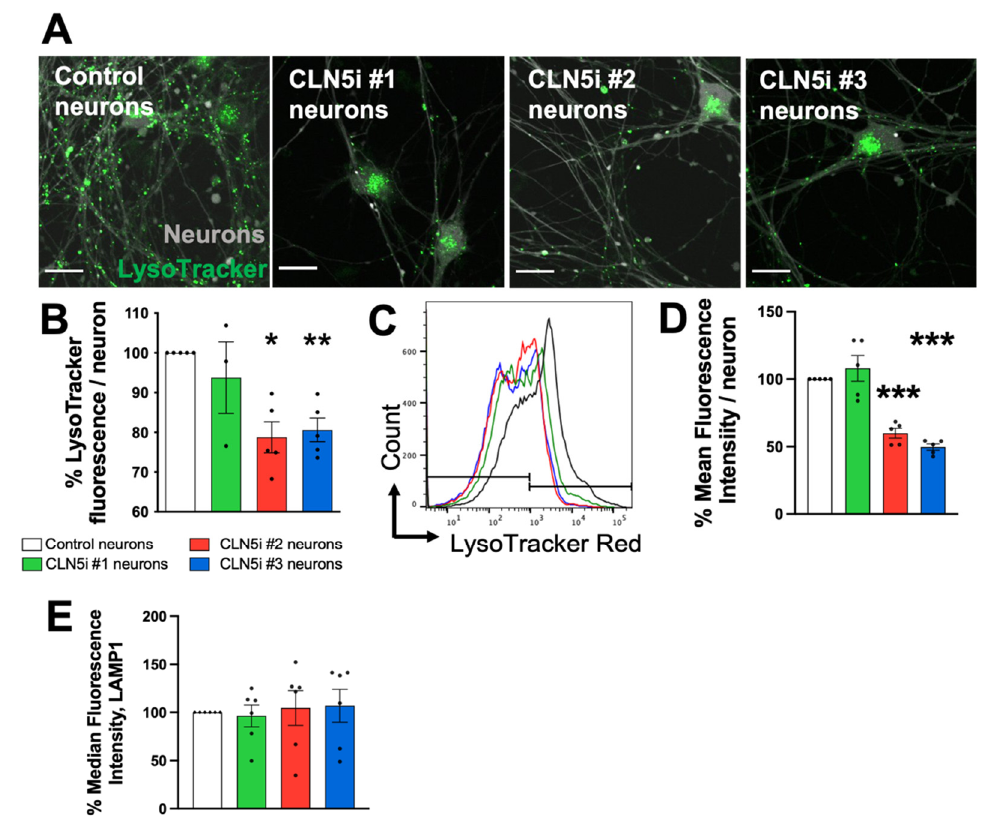
Figure 2. CLN5-deficient human neurons exhibit reduced acidic organelles. ( A,B ) Microscopic analysis of acidic organelles in the iPSC-derived human neurons revealed reduced acidic organelles (measured by LysoTracker—compare pseudo-colour green dots) in CLN5i neurons (#2 and #3) compared to control neurons. ( C,D ) The microscopic analysis of acidic organelles was validated by flow cytometric analysis. ( E ) The CLN5i human neurons did not show any difference in lysosome mass, measured by quantification of LAMP1-neuonGreen-positive organelles using flow cytometry. n ≥ 3, * p < 0.05, ** p < 0.01, *** p < 0.001. Scale bar = 20 µm.